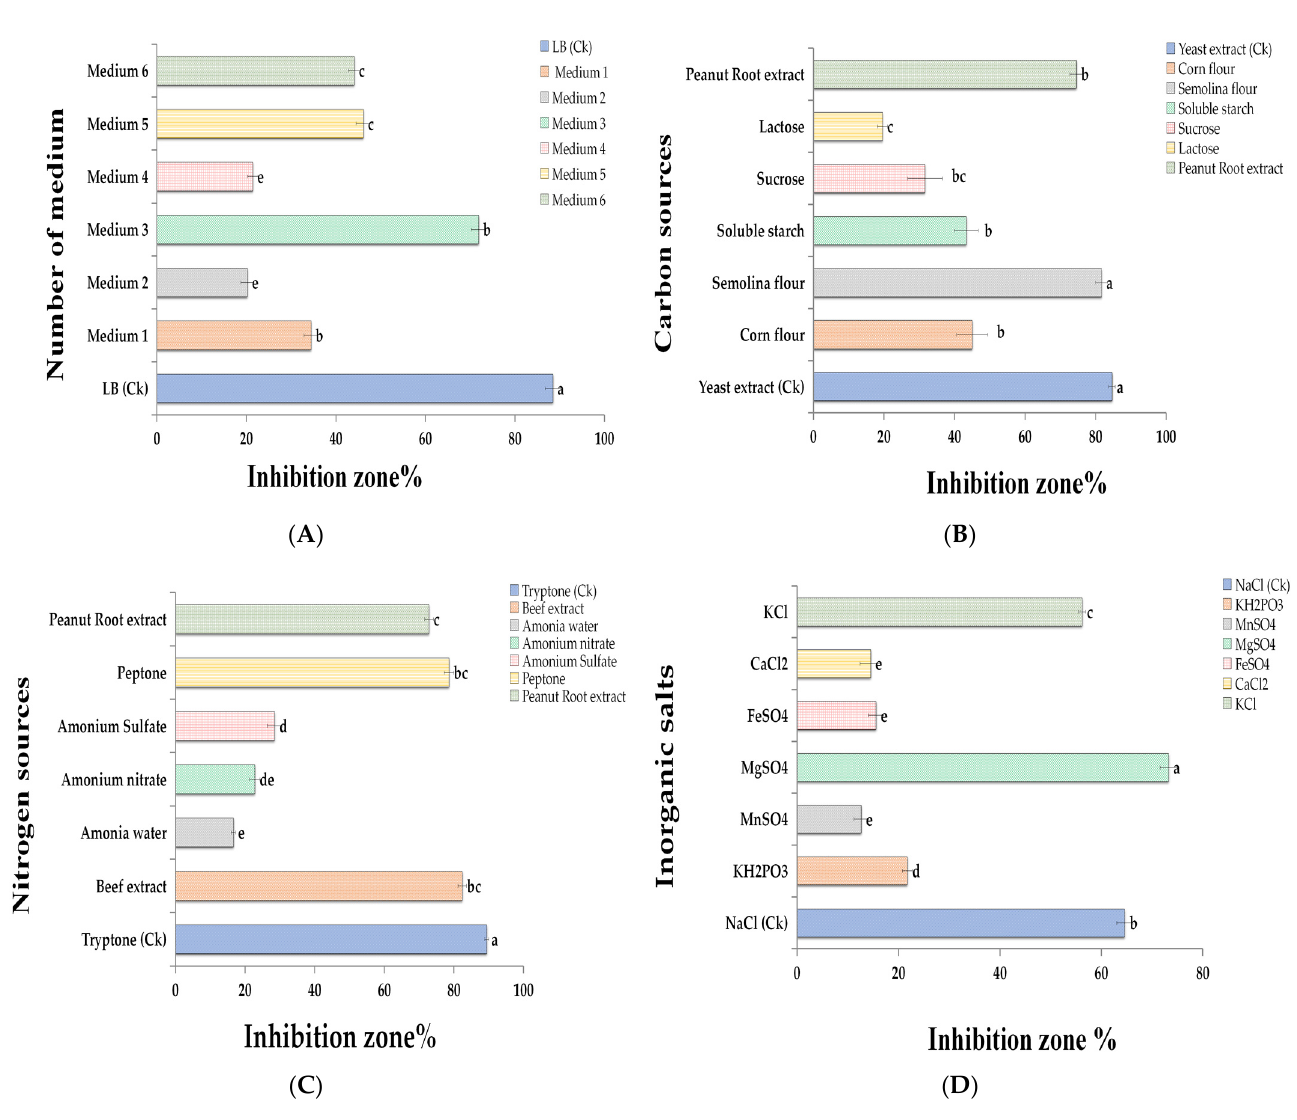
Figure 1. One-factor one-time screening of the fermentation medium of B. velezensis BP-1 (the details of the medium are given in Material and Methods). Different basal mediums ( A ), carbon sources ( B ), nitrogen sources ( C ), and inorganic salts ( D ). Inhibition zones are measured as percentages. Ck represented the control group. All of the values are comparisons of mean ± SE. According to “Tukey’s HSD” ( p > 0.05), means that share the same letter in a column are statistically insignificant. a, b, and c superscripts indicate pairwise comparisons, whether they are statistically different. To analyze the data, all treatments were repeated three times.